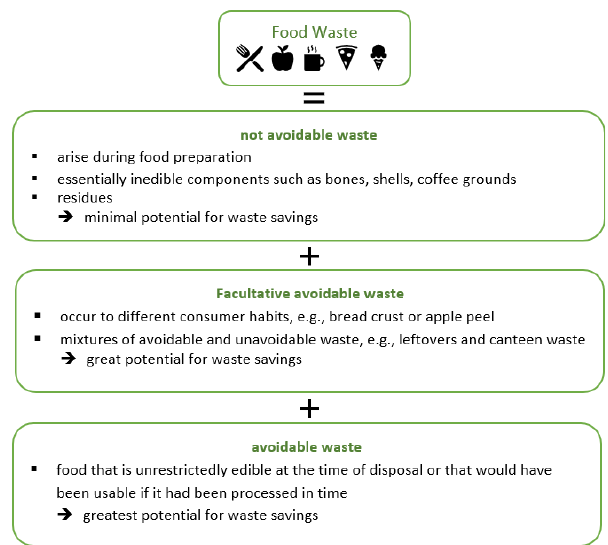
Figure 2. Food waste by avoidance potential. [5,7,12,23].